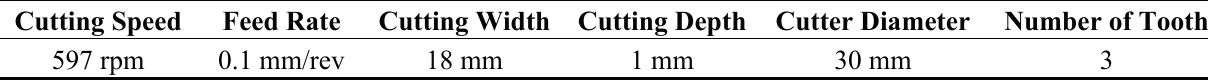
Table 1. List of cutting parameters.